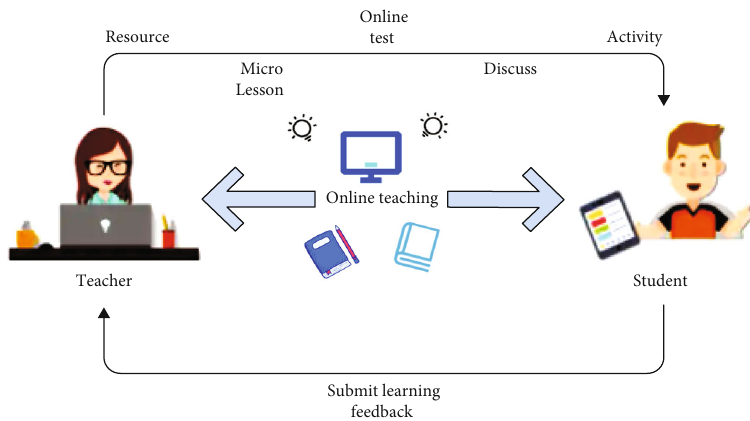
Figure 1: Network teaching